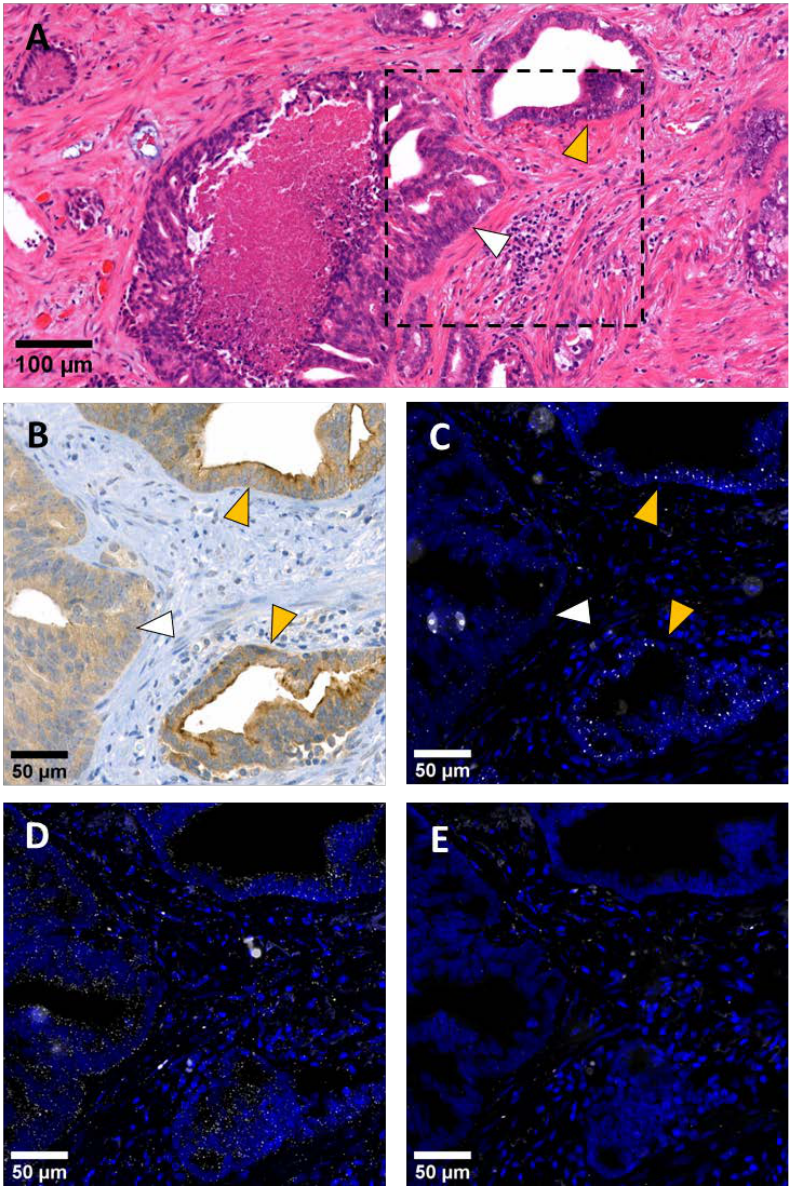
Figure 1. ANO7 protein and mRNA expression correlate in the glandular structures of the prostate. Prostate tumor tissue sections containing well-differentiated glands (yellow arrowhead) and a re- gion with high-grade cancerous growth (white arrowhead) stained with H&E ( A ), an anti-ANO7 antibody ( B ), or labelled with RNA-FISH for ANO7 mRNA ( C ), positive control PPIB mRNA ( D ), or with a negative control probe against dabB ( E ). The probe signal in ( C – E ) is shown in white and the nuclear DAPI staining in blue. The ANO7 mRNA signal ( C ) is prominent in the well-differentiated glands, which also show high anti-ANO7 staining intensity at the apical membrane ( B ). Markedly less ANO7 mRNA signal is seen in the high-grade cancerous growth region (white arrowhead), which also displays loss of apical anti-ANO7 staining. The PPIB signal is present throughout the tissue with pronounced accumulation in epithelial cells ( D ). The negative control probe dabB reveals unspecific off-target signals ( E